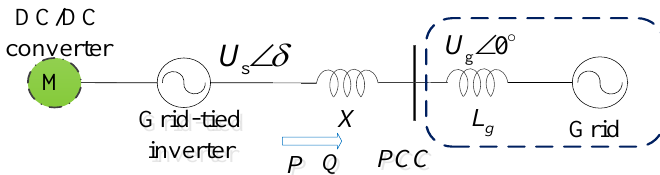
Figure 2. Simplified circuit diagram.